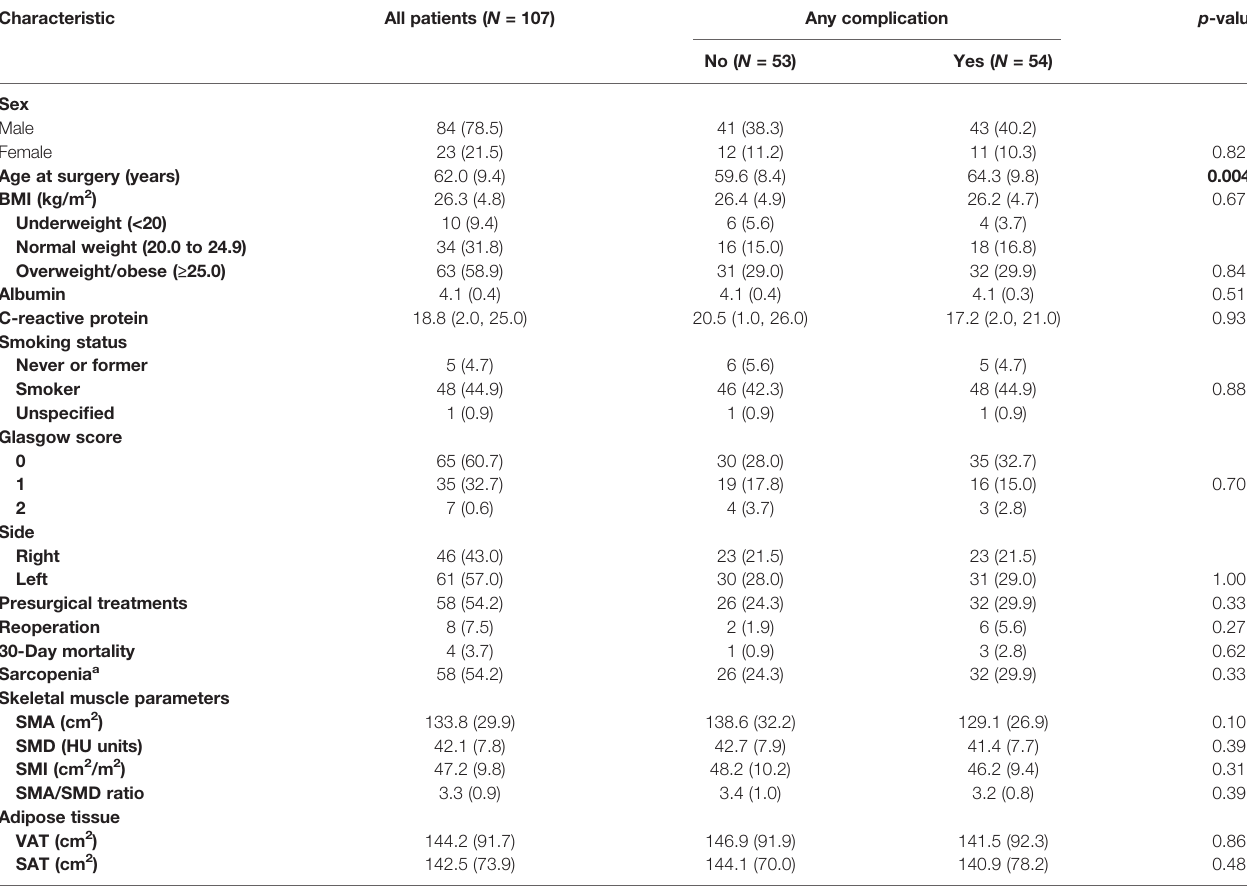
Statistics are mean (SD) for age, body mass index (BMI) (continuous), skeletal muscle parameters, adipose tissue, and albumin; mean (IQR) for C-reactive protein; and N (%) otherwise. a See Martin et al. for de fi nition. SMA, skeletal muscle area; SMD, skeletal muscle density; HU, Houns fi eld units; SMI, skeletal muscle index; VAT, visceral adipose tissue; SAT, subcutaneous adipose tissue. Bold p-values are signi fi